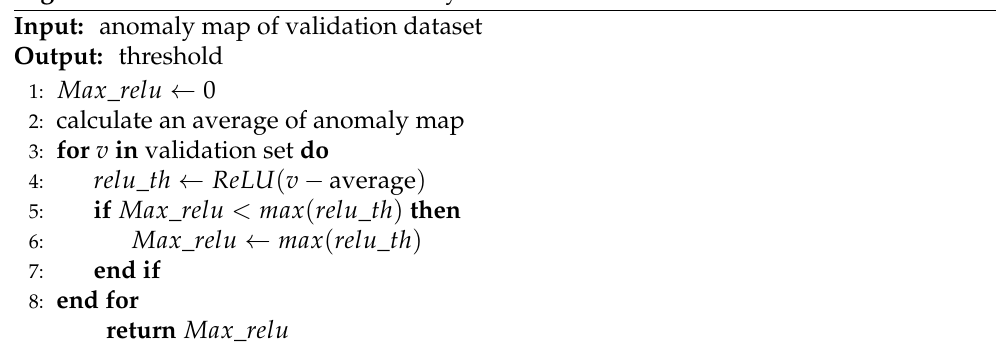
Algorithm 1 Find threshold for anomaly